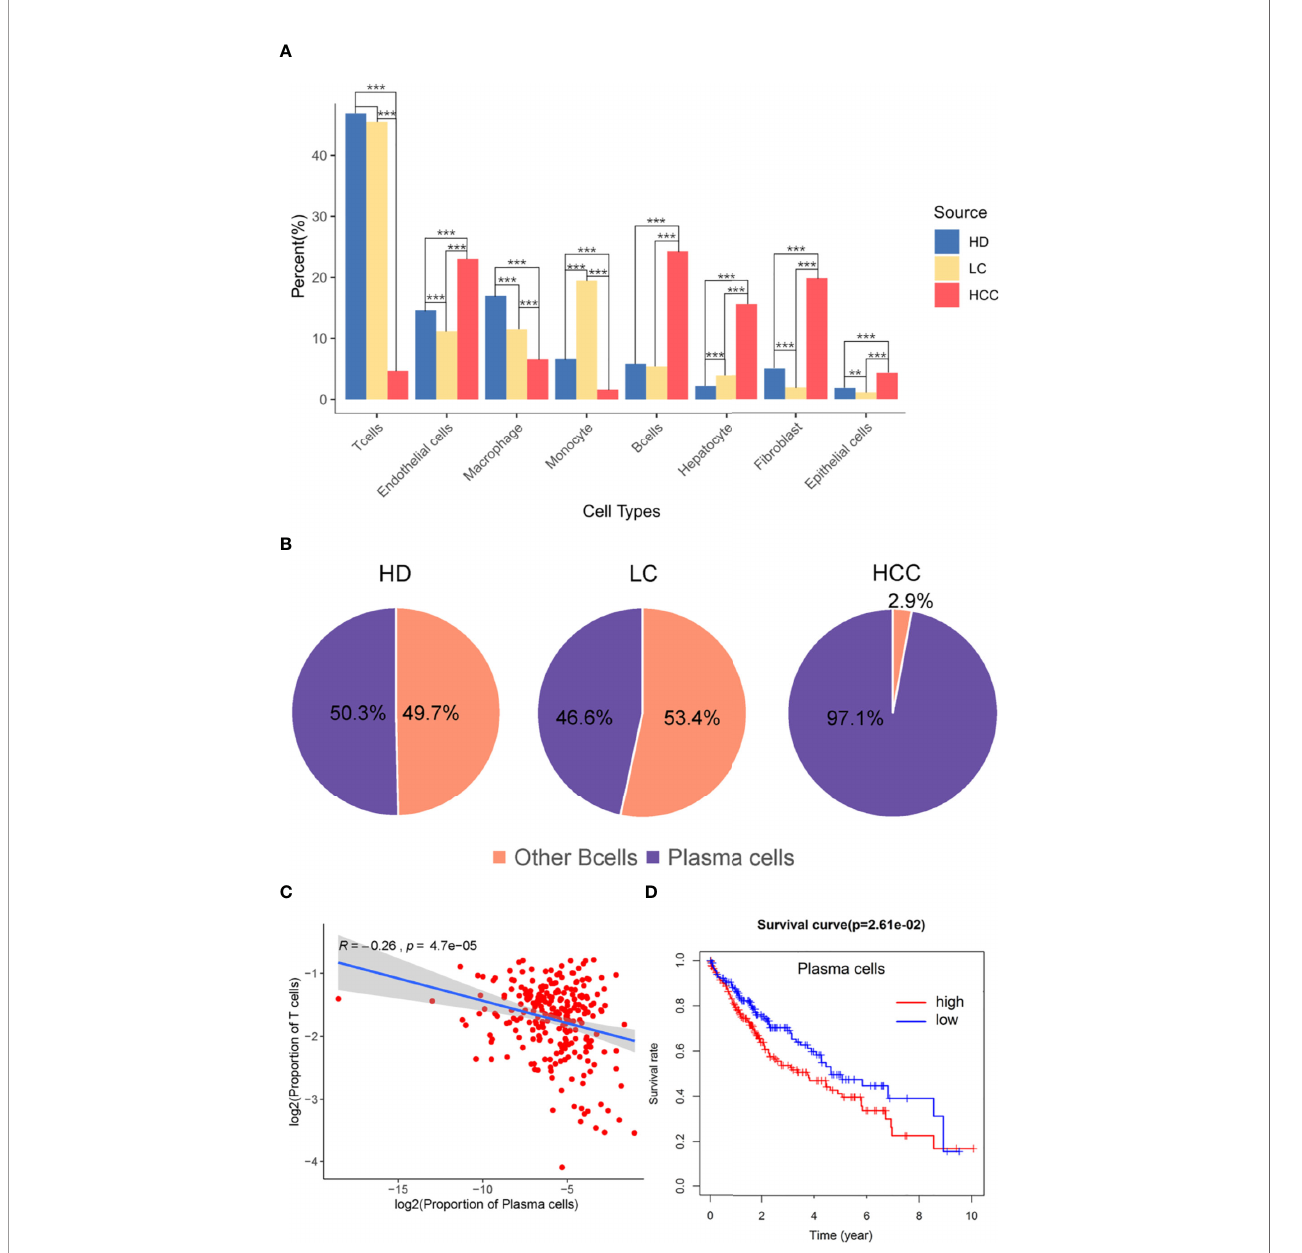
FIGURE 2 | The role of plasma cells in the tumor microenvironment. (A) Bar plot showing the cell percent of different cell types in three sources, healthy donors (HD), patients with liver cirrhosis (LC), and patients with hepatocellular carcinoma (HCC). * p.adjust < 0.05, ** p.adjust < 0.01, and *** p.adjust < 0.001 (Fisher ’ s exact test). P.adjust values were calculated using Benjamini and Hochberg method. (B) The proportion of plasma cells and other B cells in the three sources. (C) Correlation of the plasma cells signature with T cells (TCGA LIHC data). Each dot represents a patient (Pearson ’ s correlation analysis). (D) Correlation between the proportion of plasma cell with survival rate, red is high proportion, blue is low proportion, p < 0.05 (Cutoff point =